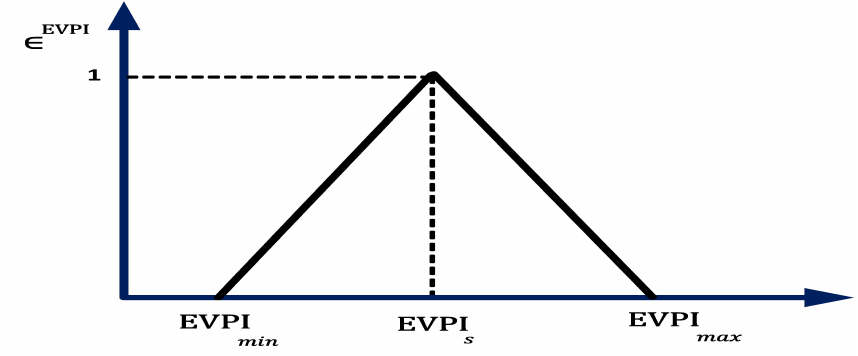
Figure 6. EV real power